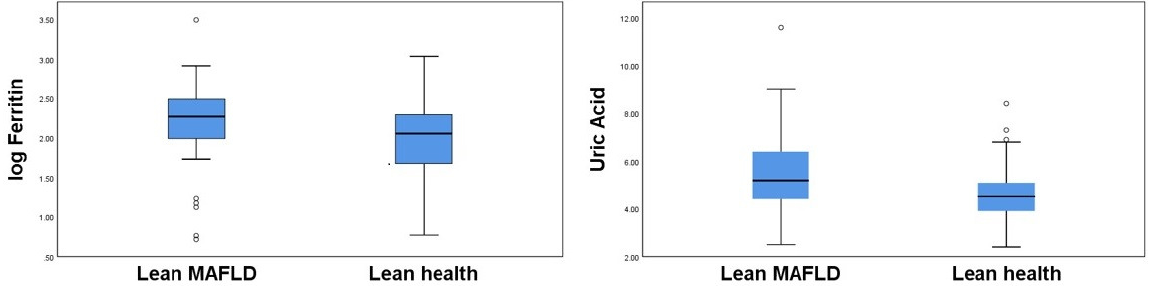
Figure 2. Box plot representation of ferritin and uric acid in lean MAFLD and healthy control group. Figure 3 shows the number of metabolic abnormalities in the lean MAFLD group. The prevalence of prediabetes in lean MAFLD subjects was 92% (45/49), followed by hypertension (57%,